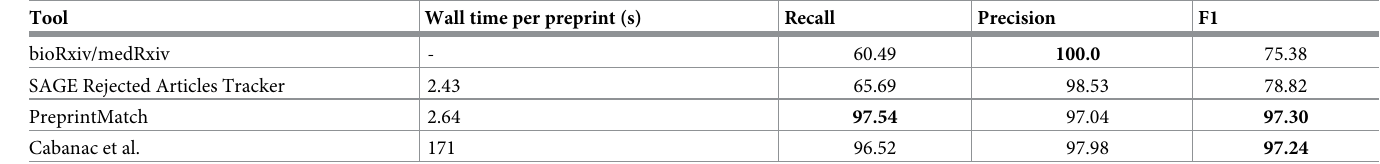
Table 2. Tool comparison on Cabanac et al.’s dataset.